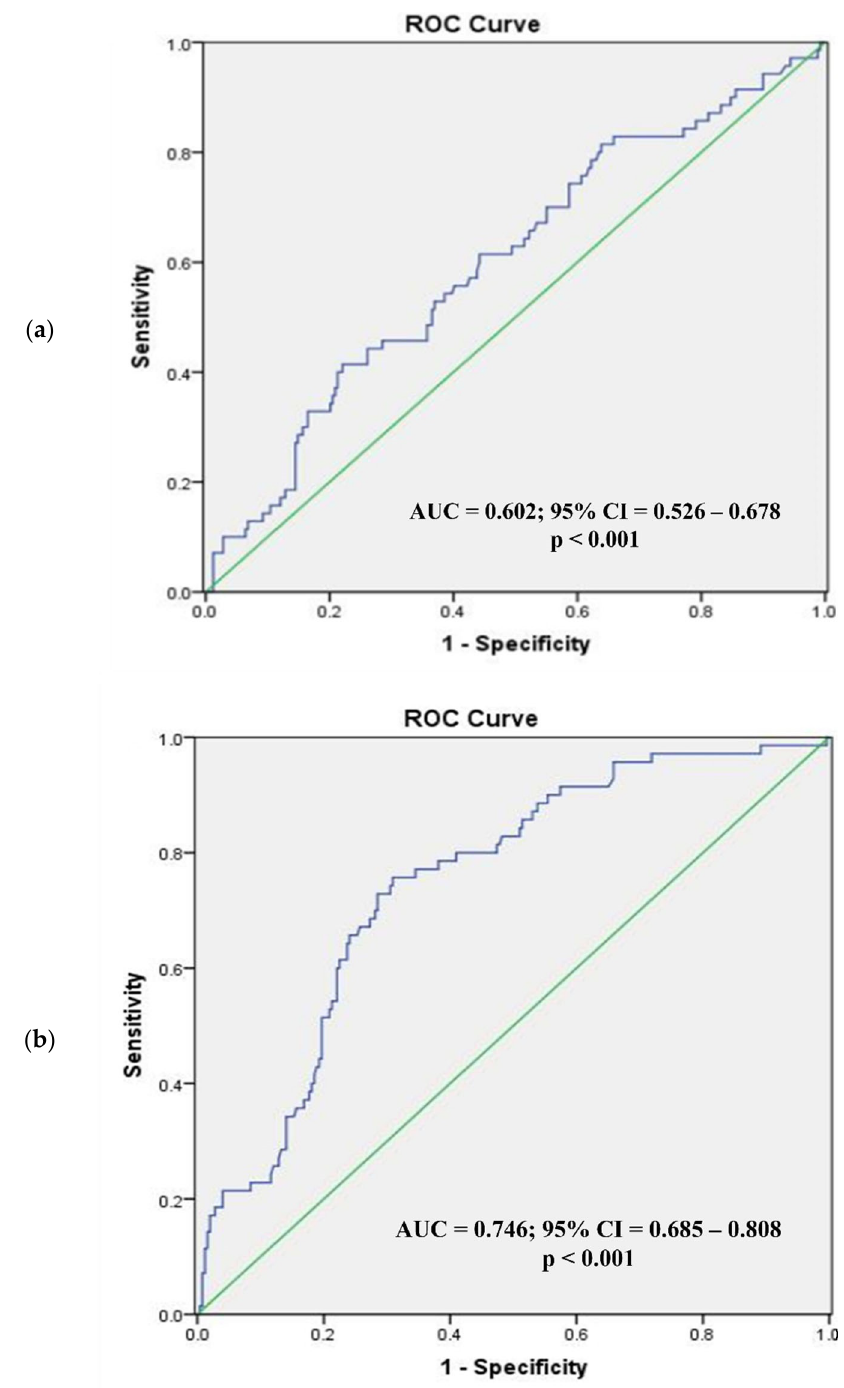
Figure 3. Receiver operating characteristic analysis of women with normal BMI (body surface area ( a ), body mass index ( b )). In normal-weight women, the AUC for BSA ( a ) was 0.602 (95% CI = 0.526–0.678; p < 0.001) and for BMI ( b ) 0.746 (95% CI = 0.685–0.808; p < 0.001). ROC, receiver operating characteristic; AUC, area under the curve; CI, confidence interval.